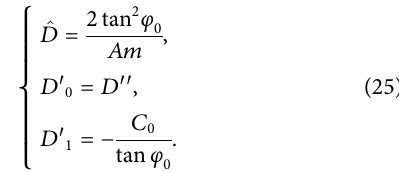
Frontiers in Earth Science |